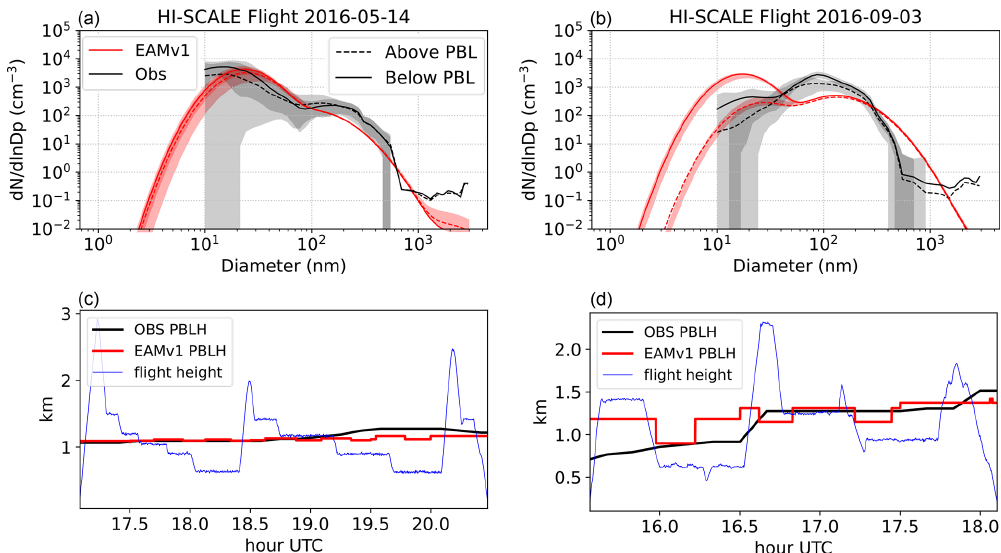
Figure 6. (a–b) Mean aerosol number distribution for two flights during HI-SCALE, (a) 14 May 2016 and (b) 3 September 2016, for data above (dashed line) and below (solid line) the observed PBLH. If there is cloud observed within a 1h window of the sample point, the above-PBL sample needs to be above cloud top and the below-PBL sample needs to be below cloud base for the sample point to be chosen. Shadings represent the data range between the 10th and 90th percentiles. Relatively large particles with no shading indicate more than 90% of samples with zero values. (c–d) Time series of the observed (black) and simulated (red) PBLH overlaid with flight height (blue) during the two flight periods. The observed PBLH is derived from Doppler lidar